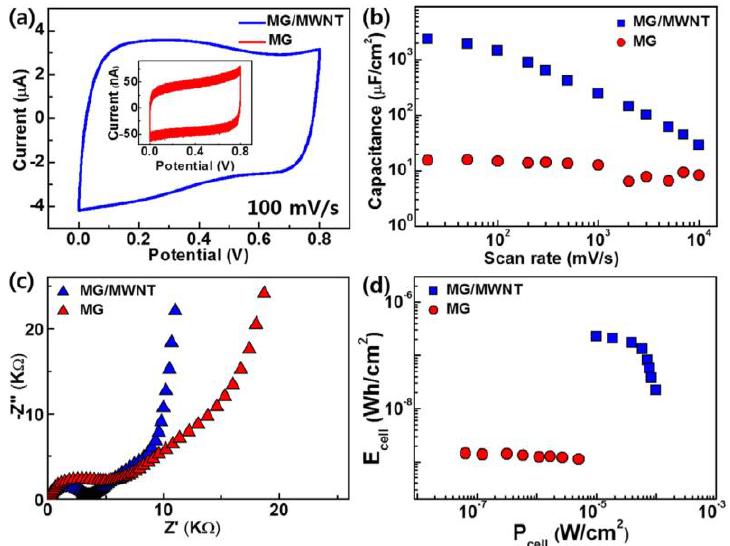
Figure 14. Electrochemical performance of supercapacitors with MWCNT and monolayer graphene composite electrodes in all-solid-state supercapacitors (PVA-H 3 PO 4 gel electrolyte) [118]. Cyclic voltammetry is shown in ( a ). The variation of area-specific capacitance with scan rate is shown in ( b ). Impedance spectra are shown in ( c ). Specific energy and specific power are plotted in ( d ). Used with permission from Elsevier.